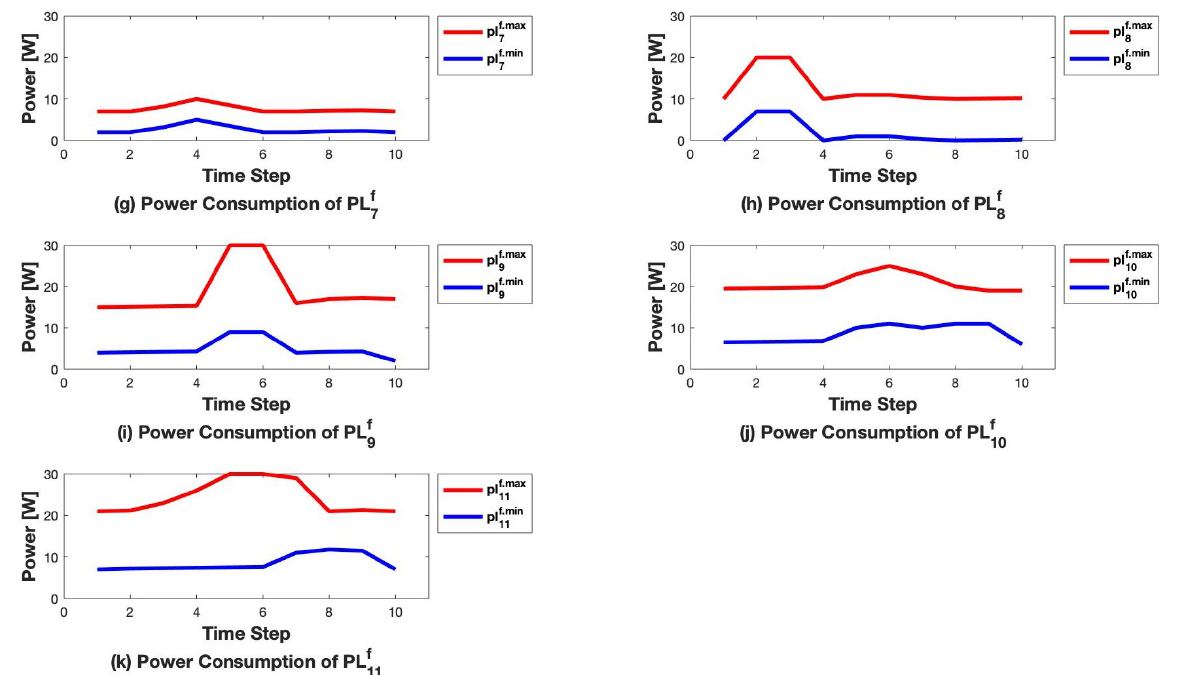
Figure 19. Time dependent power consumption